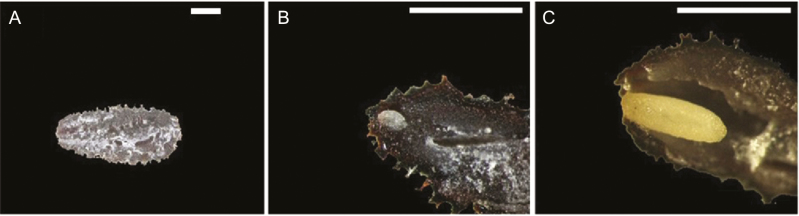
Embryo growth for after-ripened seeds of Anigozanthos flavidus in this study was demonstrated by continually measuring the increase in length (mm) of embryos during incubation at suitable temperatures (see Fig. 4). Examples of an intact seed (A), embryo before growth (B) and embryo before germination (C) are shown visually here. Scale bar = 1 mm.